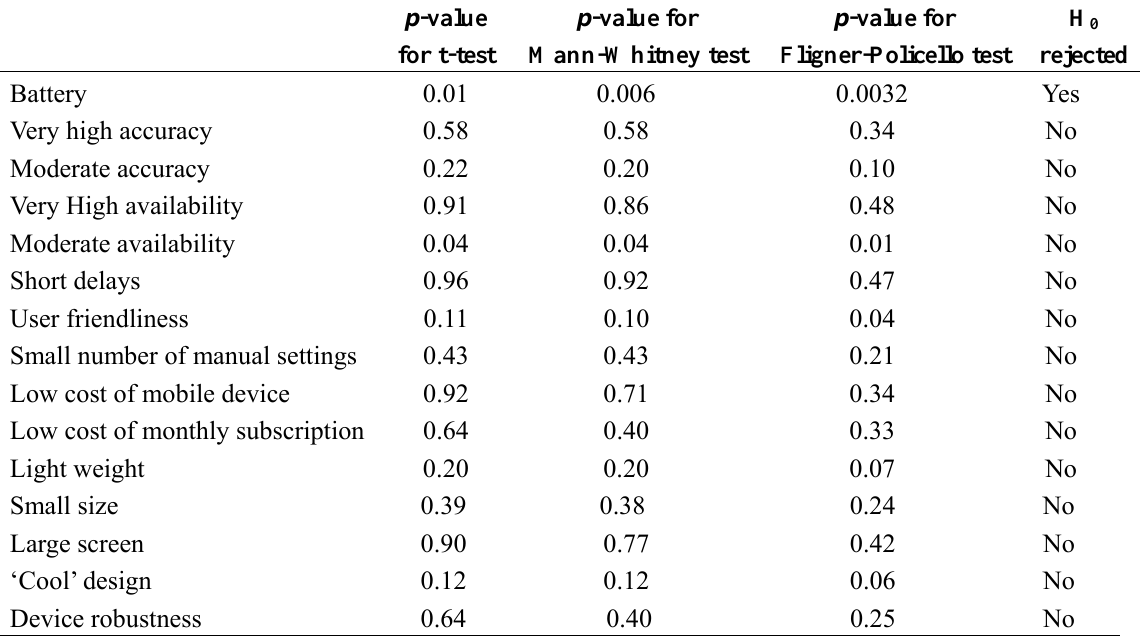
Table 5. Correlation between TUT and UPB groups regarding mobile device preferences.